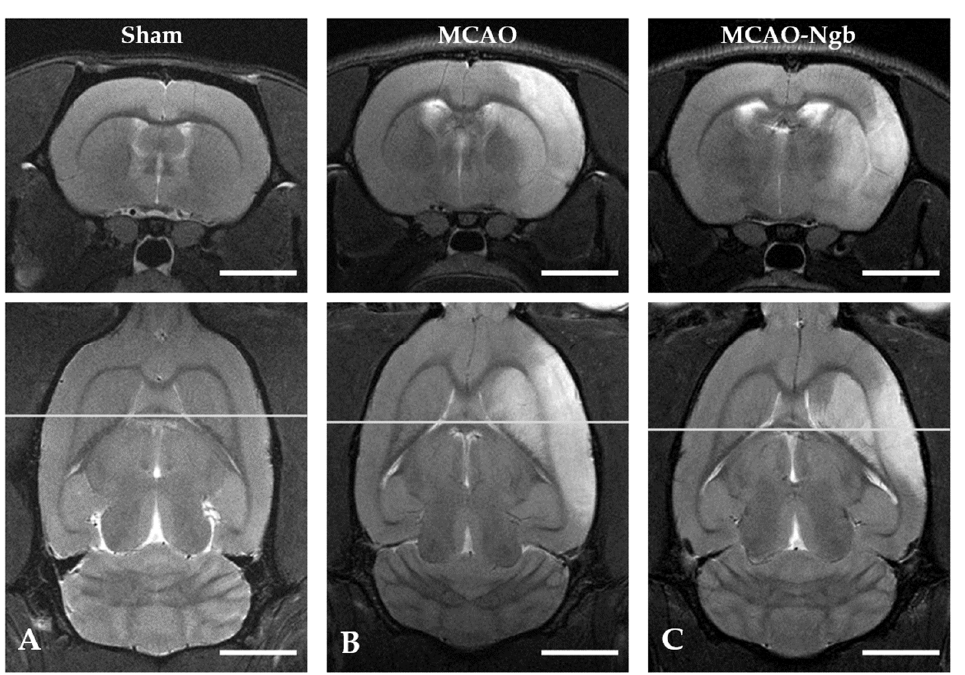
Figure 5. Confocal microscopy images of the infarcted zone from a MCAO-Ngb animal after 24 h of reperfusion. Rhodamine red fluorescence detects the Ngb-NPs, whereas Cy2 green fluorescence binds to NeuN (neurons): Ngb attached to NPs appears in yellow, due to green and red merge. Cy5 dye bound to GFAP (astrocytes) is digitally shown in grey, and DAPI dye marks cell nuclei in blue. ( A ) Merge image showing neurons (NeuN) stained in green with yellow cytoplasmatic vesicles containing Ngb-NPs. Astrocytes are shown in grey. Only few red Ngb-NPs not associated with neurons are observed. ( B – D ) Higher magnification of the zone delimited by the white square in image ( A ).